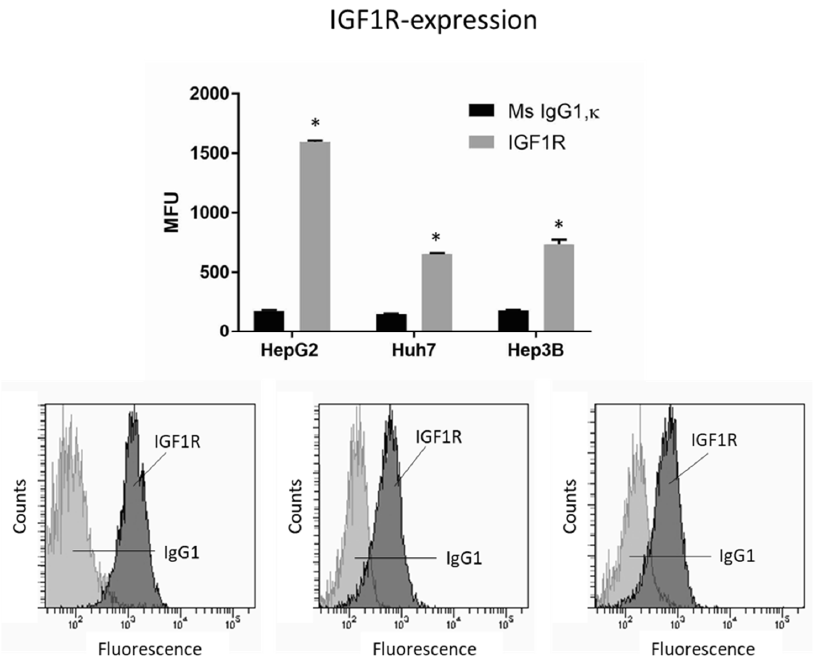
Figure 5. IGF1R expression level in HepG2, Huh7, and Hep3B cell lines. MFU depicts mean fluorescence units. * indicates significant difference to Ms IgG1 ( n = 3). Flow cytometry curves are representative for one of the three experiments. Stimulation with IGF1 induced a significant upregulation of the integrins α 2, α V, and β 1 (Figure 6A) and induced a significant increase of HepG2 cell attachment to immobilized collagen and forced invasive movement (Figure 6B, 6C and 6D, respectively) ( p -values ** 0.0035, **** <0.0001, **** <0.0001, **** <0.0001, respectively). Blocking the integrins α 2 and β 1 with respective monoclonal antibodies or with BTT3033 or blocking α V β 3 by Cyclo counteracted the IGF1 triggered adhesion and invasion (Figure 6B,C,D). Knockdown of α 2, α V, or β 1 was also associated with a significant reduction in the HepG2 invasion (Figure 6E) ( p -values **** <0.0001, **** <0.0001, **** <0.0001, respectively)